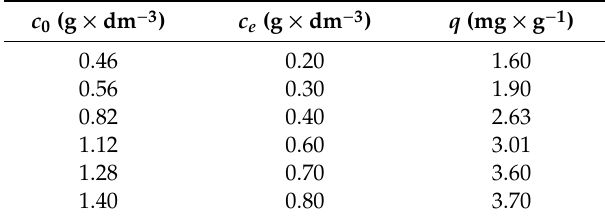
Table 1. Equilibrium concentrations of Fe 3+ in solutions and adsorbed amounts relative to different initial concentrations.